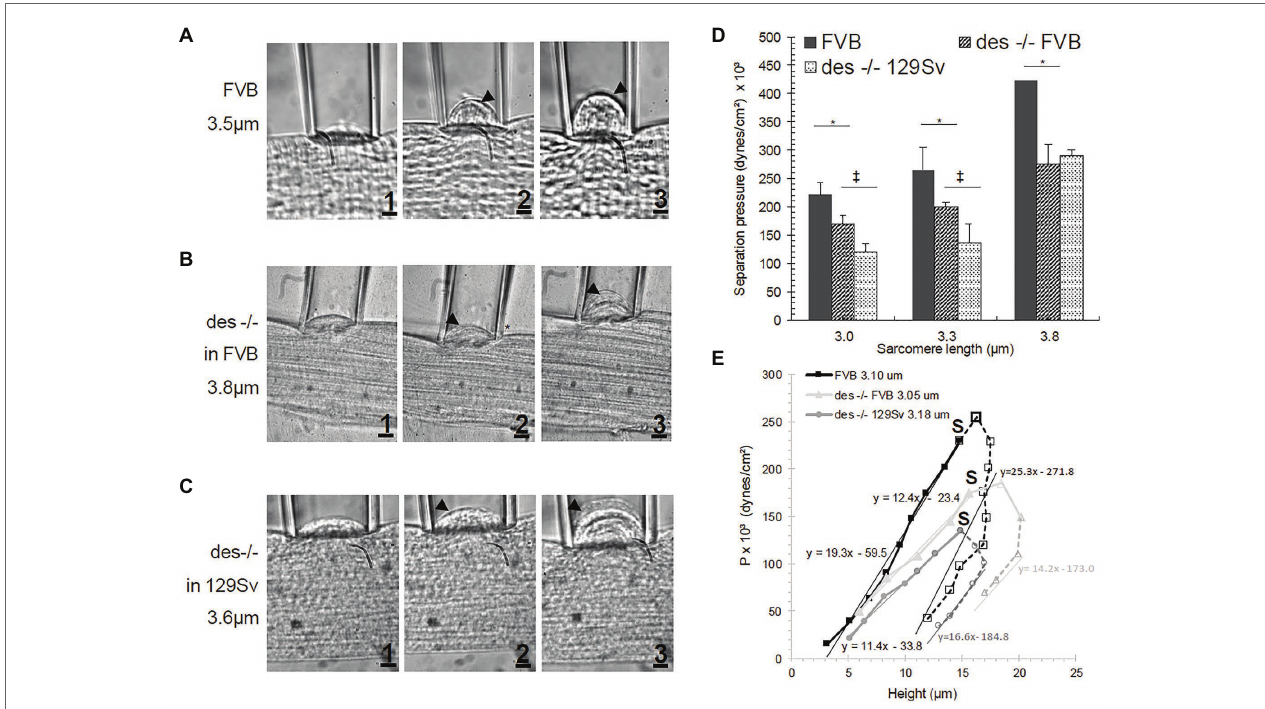
FIGURE 2 | Sarcolemmal bleb increasing in size with increasing suction pressure (1-3) in (A) FVB, (B) des −/− FVB or (C) 129Sv muscle fibers. Arrowhead represents the separation of the sarcolemma from the cytoskeleton. (D) Effect of SL on separation pressure in FVB and des −/− mice. Bars indicate mean ± SD. *Significant difference between des −/− FVB and its control strain at the same SL. ‡ Significant difference comparing both des −/− mutants in different background strains. Statistical analysis was performed with a one-way ANOVA with a Tukey post hoc test. (E) P-h curve in FVB and des −/− (in FVB and 129Sv background) myofibers. Filled symbols and solid lines represent data before separation of the sarcolemma from the contractile elements. Open symbols and segmented lines represent data after separation. S denotes P separation . Regression lines equations are given for each strain. P separation for des −/− was smaller than for WT, indicating a weaker attachment of the sarcolemma to underlying contractile